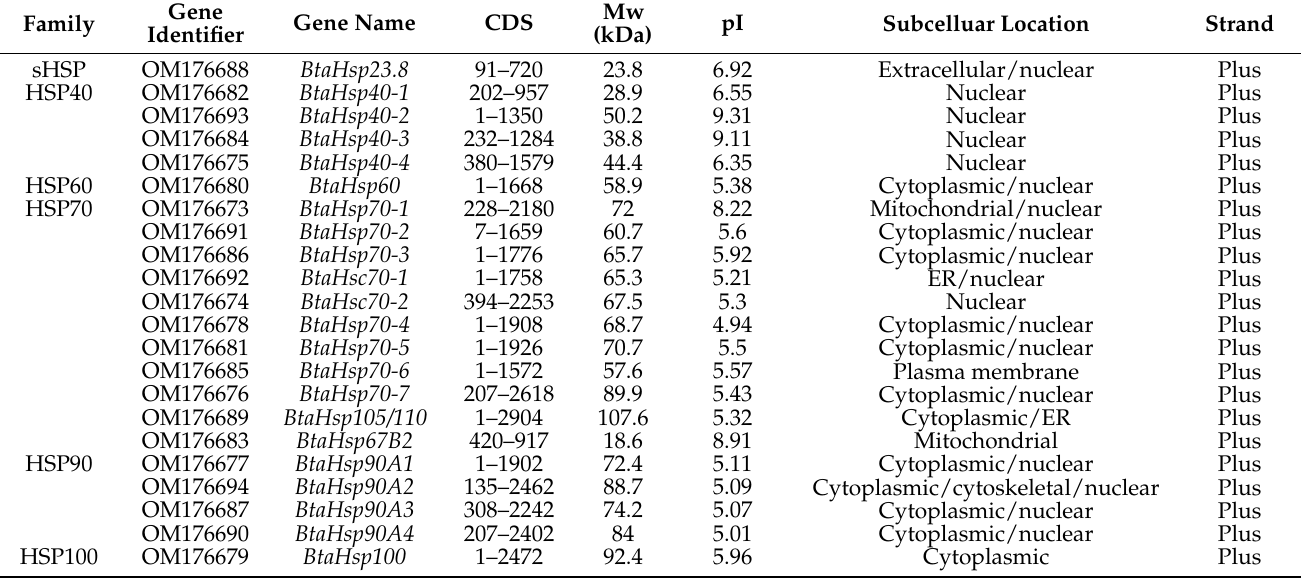
Table 1. Information on HSP genes superfamily in Bemisia tabaci